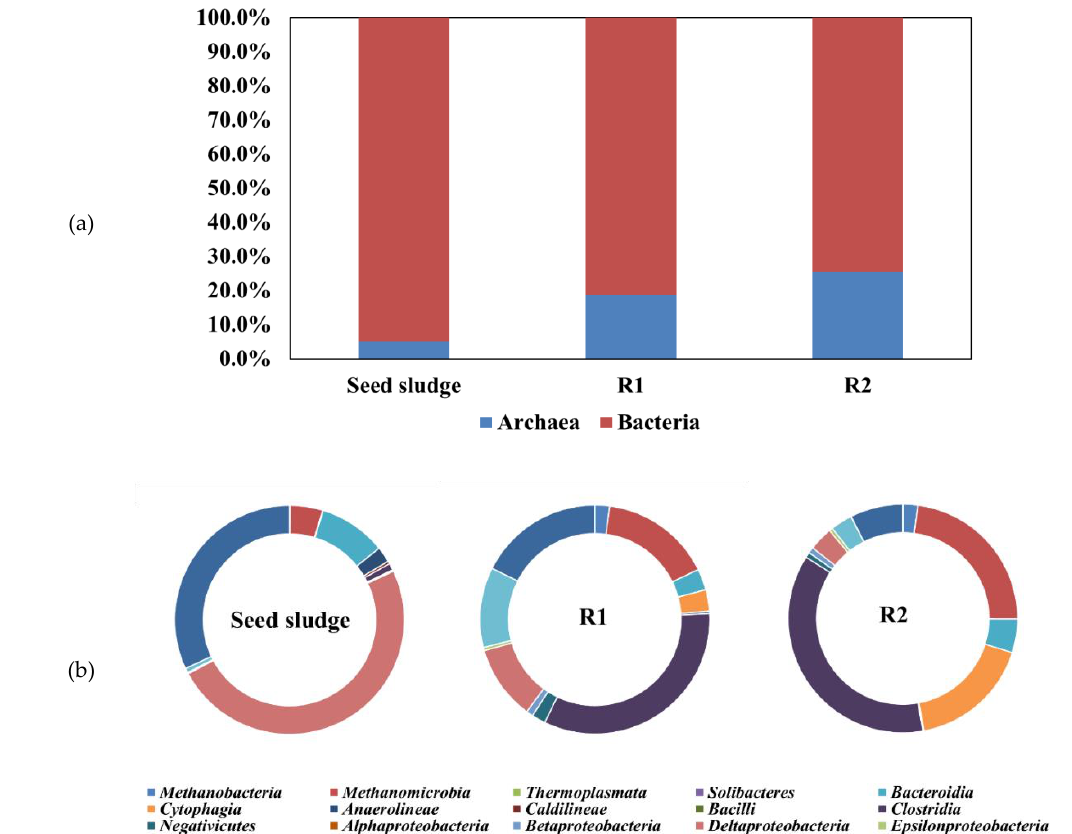
Figure 3. Relative abundances of microorganisms of seed sludge, R1 (with CHM), and R2 (with PHM) at ( a ) kingdom level and ( b ) class level (Seed sludge: the sample was taken from the seed sludge; R1 and R2: the samples were taken at the end of operation).